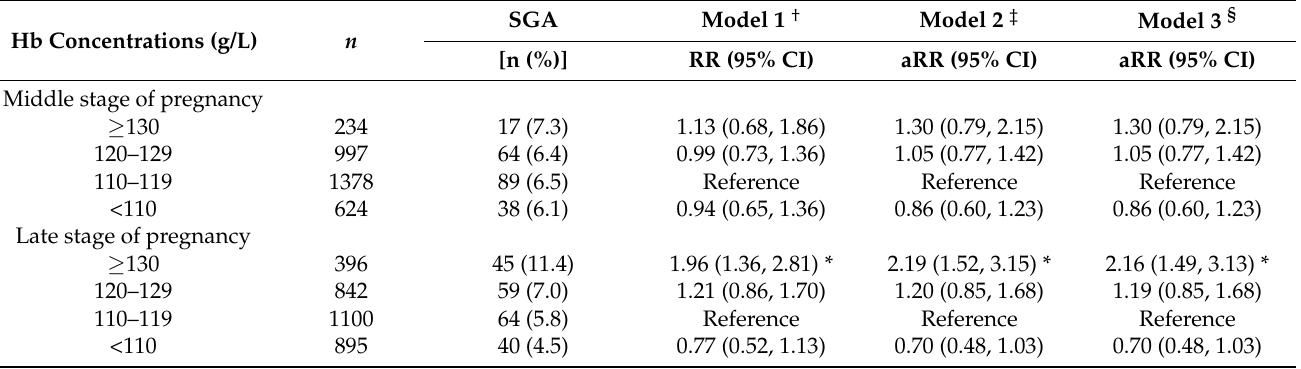
Table 3. Associations between Hb concentrations in the middle and late stages of pregnancy and SGA.